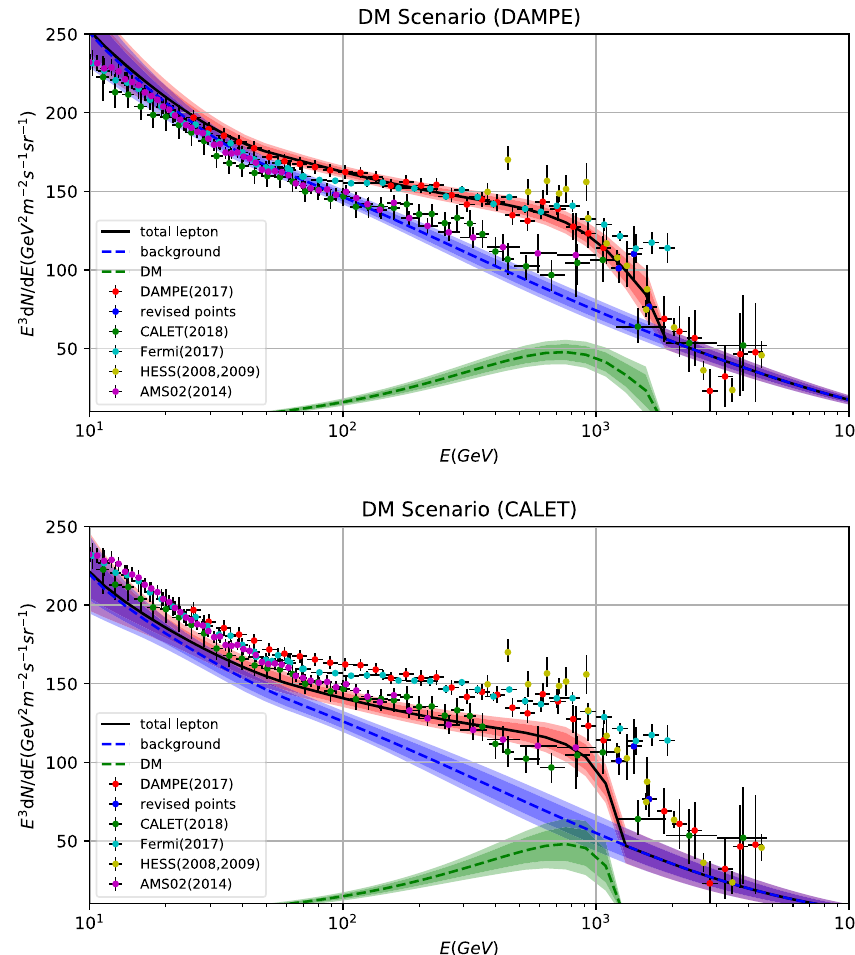
Fig. 2 The global fitting results of the DAMPE and CALET lepton flux for DM scenario. The 2 σ (deep color) and 3 σ (light color) bounds of the total fitted results (red), and the contribution from background (blue) and DM (green) are also shown in the figure. We have χ 2 (cid:2) 13 . 9 (DAMPE) and χ 2 (cid:2) 25 . 7